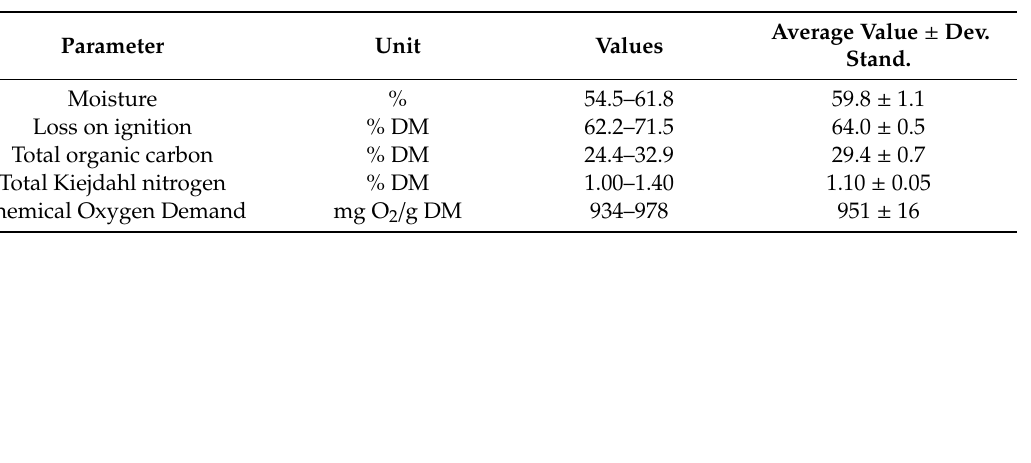
Table 2. Physicochemical properties of the bio-waste used in the